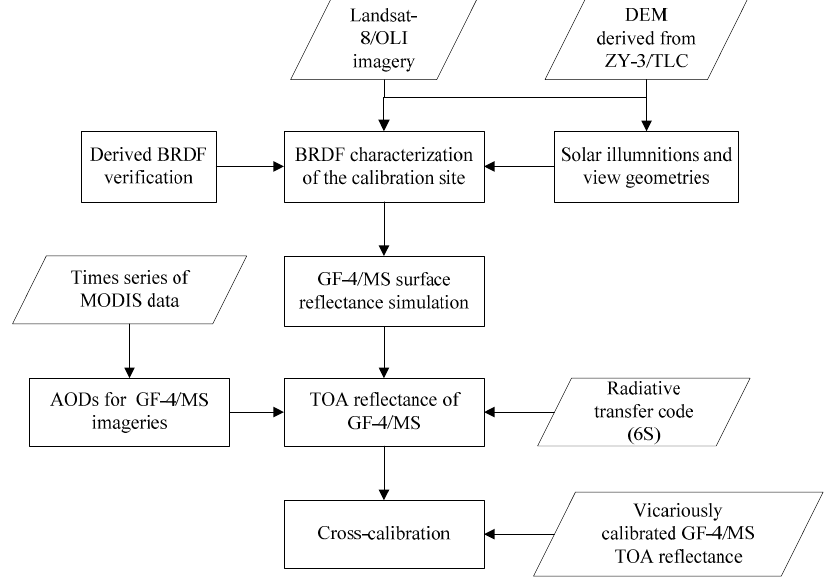
Figure 1. Illustration of the procedure of the new cross-calibration approach (parallelogram is the input and rectangle is the process).